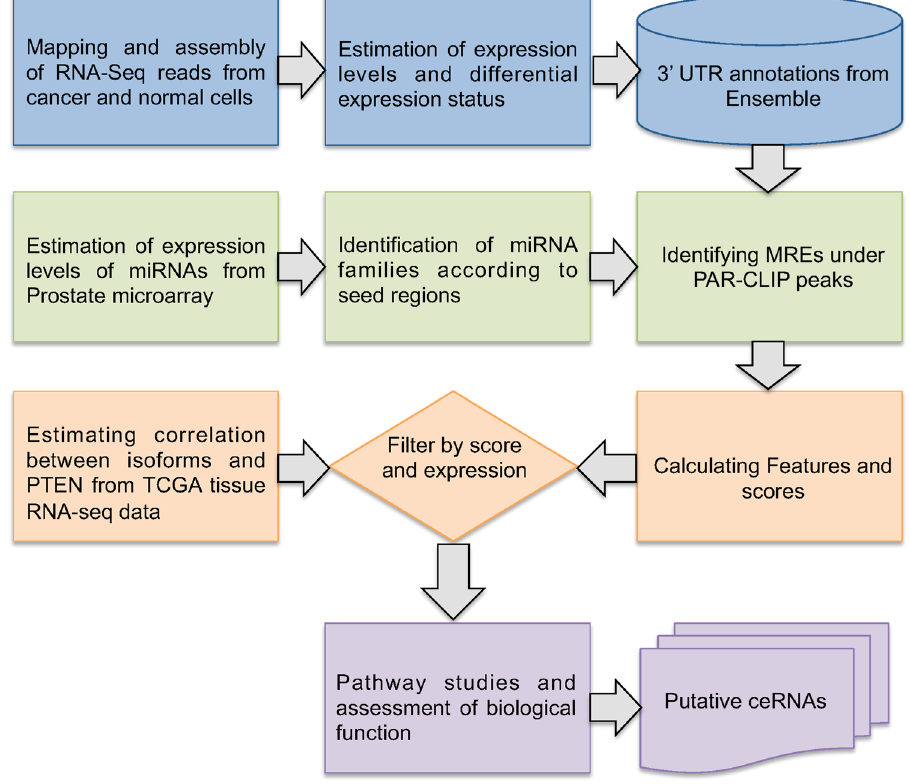
Figure 2. Data Processing pipeline. Figure shows a schematic representation of the data processing pipeline for prediction of putative